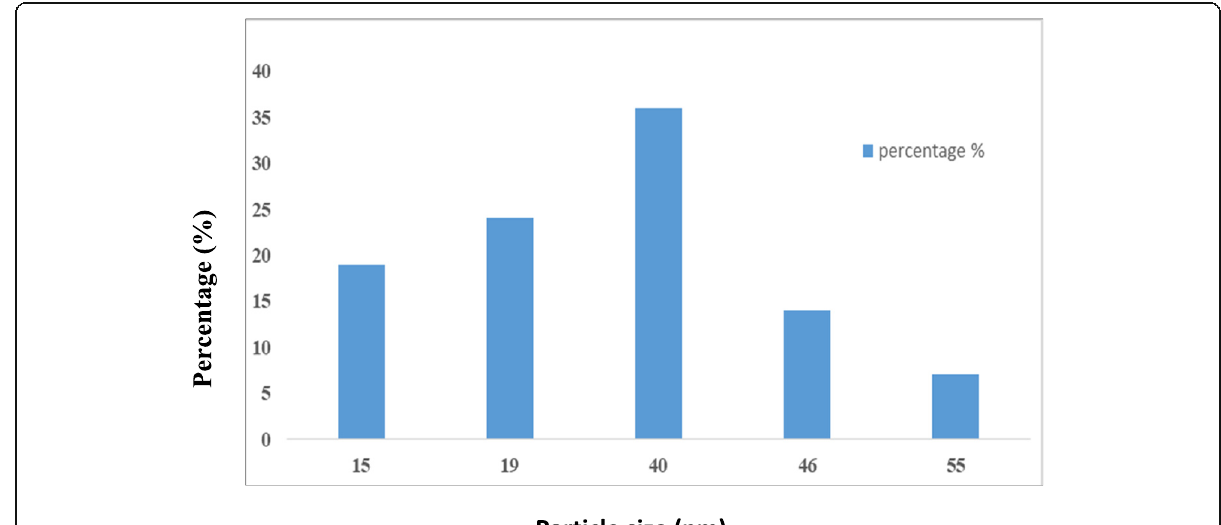
Fig. 3 Histagram of banana peel extract using alkaline extraction